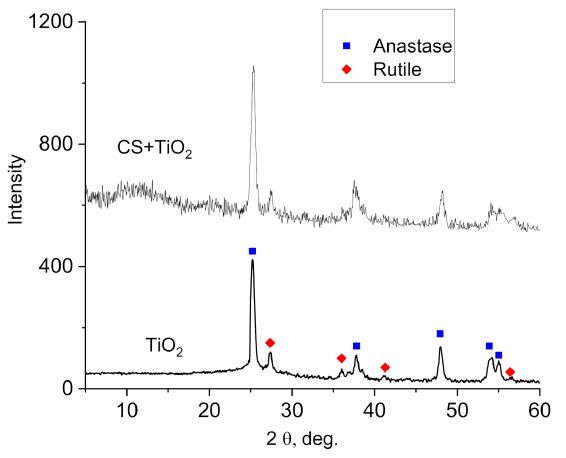
Figure 2. XRD pattern of TiO 2 NPs and CS–TiO 2 film with 40 wt.% of